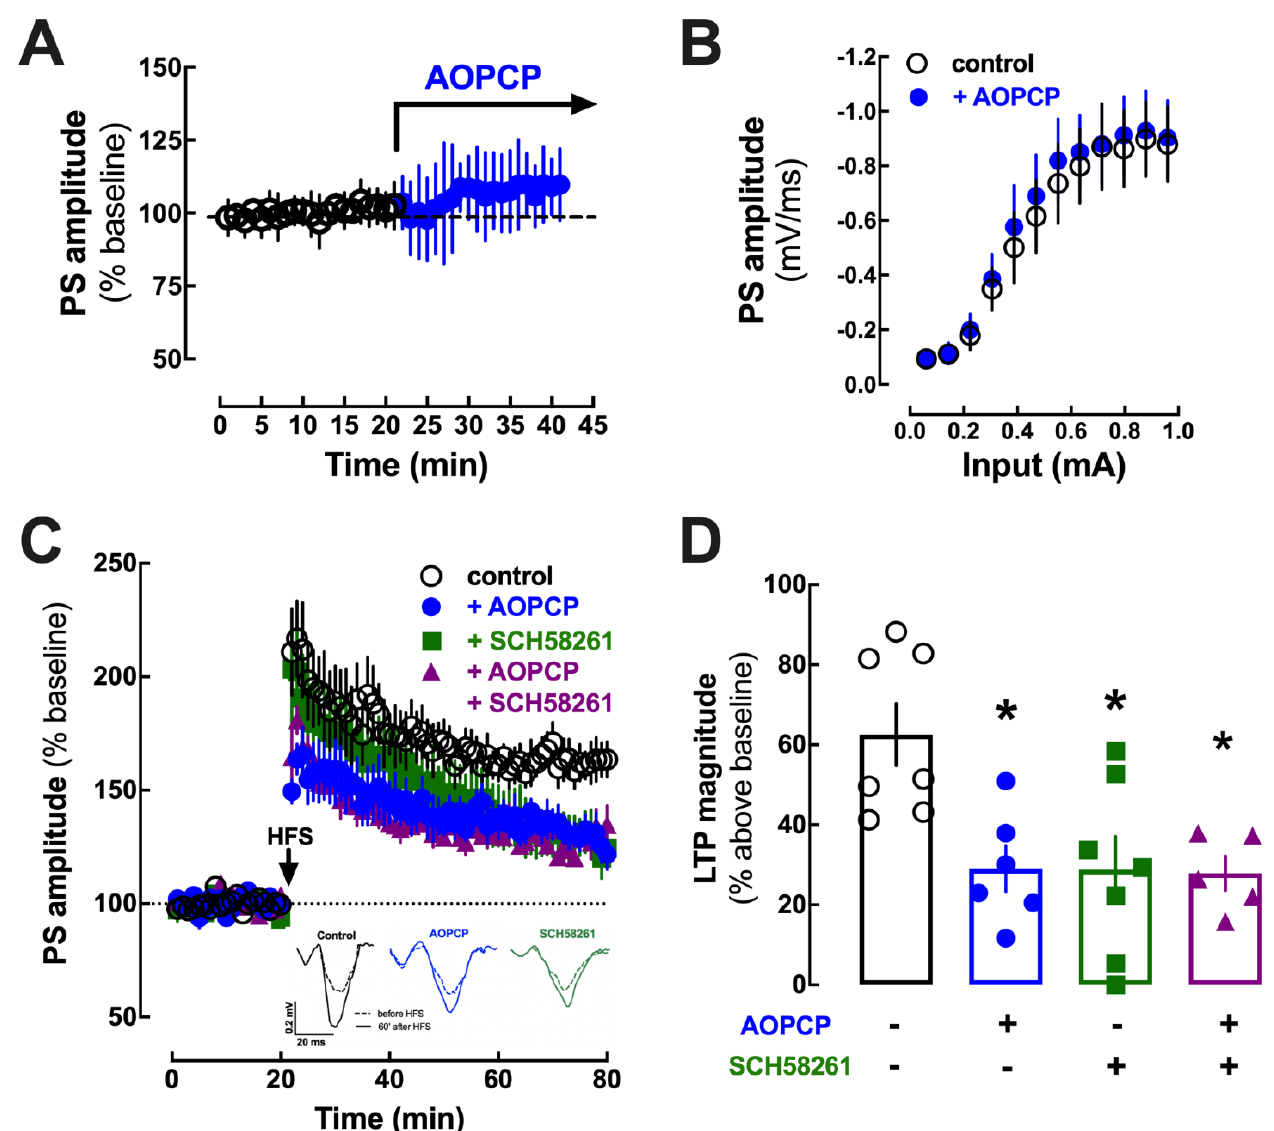
Figure 6. CD73 derived adenosine activates A 2A R controlling LTP in amygdala slices. The CD73 inhibitor, AOPCP (100 µ M), did not significantly affect basal transmission ( A ) or input–output (I/O) curves ( B ) at excitatory synapses between projections of the external capsule (EC) and the lateral amygdala (LA). ( C , D ) However, the magnitude of LTP at EC-LA synapses induced by high-frequency stimulation (HFS: 3 × 100 Hz at 5 s intervals) was decreased by AOPCP (100 µ M) and by the antagonist of A 2A R (SCH58261, 50 nM), which were added to the aCSF 20 min before HFS and remained until the end of the experiment; furthermore, there were no synergistic effects between both tested drugs. The values are mean ± SEM of n = 9–10 for baseline and I/O curves and n = 5–7 for LTP experiments; * p < 0.05, one-way ANOVA followed by Bonferroni’s post hoc test. The insert in ( C ) shows representative trace recordings of population spikes recorded at EC-LA synapses before HFS (dashed lines) and 60 min after HFS (filled lines) without added drugs (black) or in the presence of either 100 µM AOPCP (blue) or 50 nM SCH58261 (green).